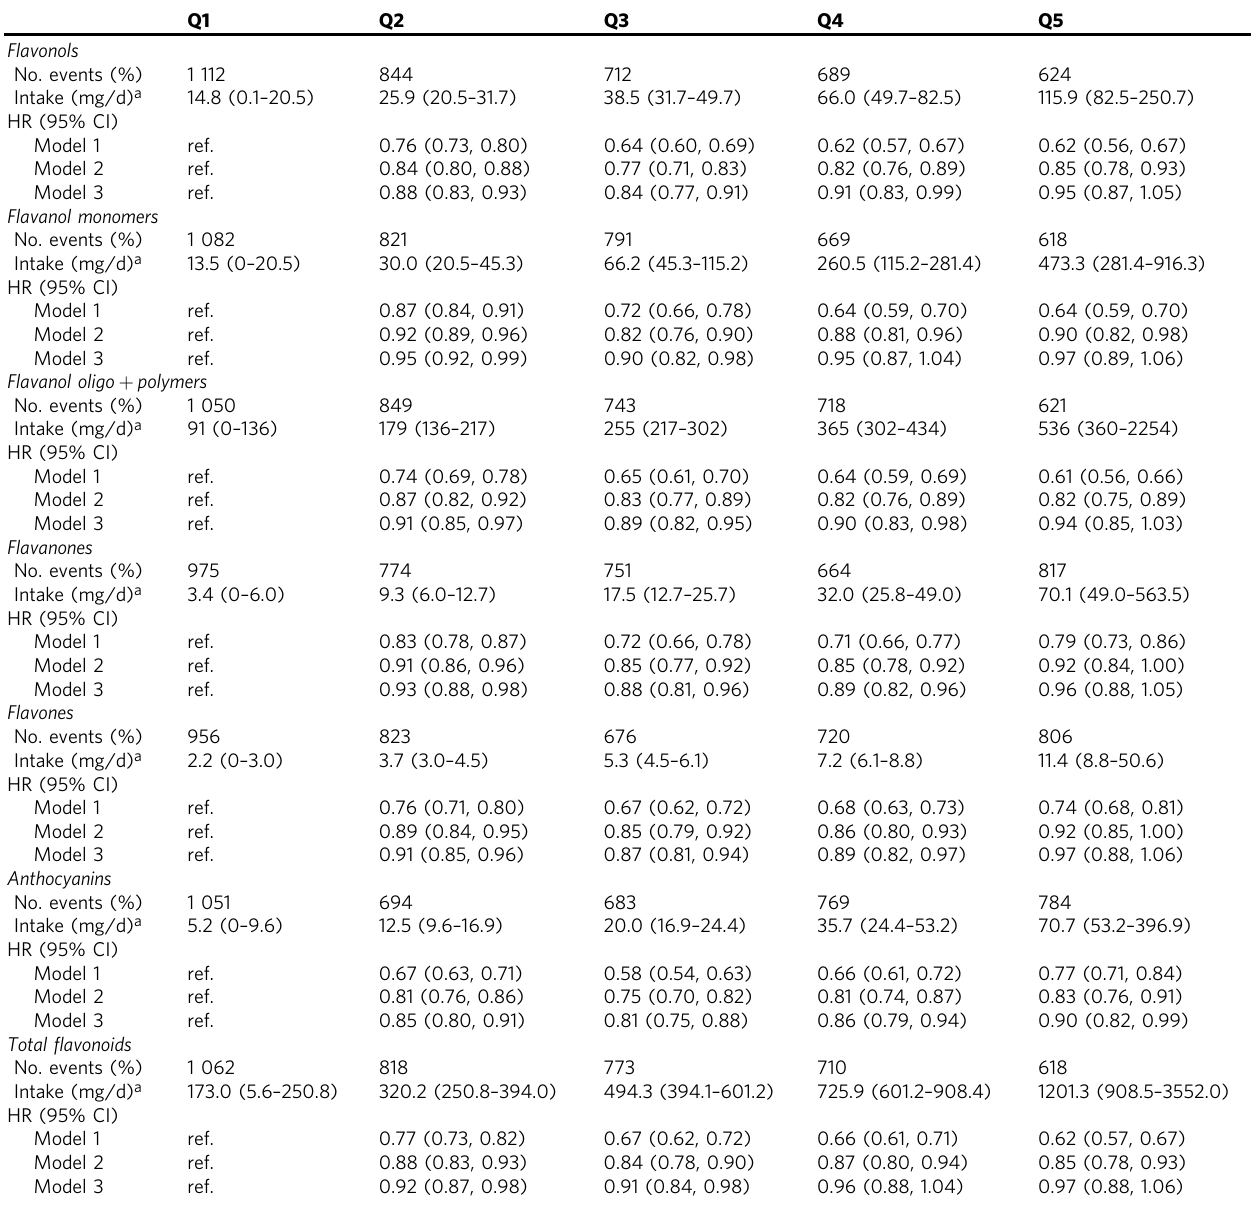
Hazard ratios (95% CI) for 23-year cardiovascular disease-related mortality, in participants without cardiovascular disease at baseline ( n = 52 492), obtained from restricted cubic splines based on Cox proportional hazards models. Model 1 adjusted for age and sex; Model 2 adjusted for age, sex, BMI, smoking status, physical activity, alcohol intake, hypertension, hypercholesterolemia, social economic status(income),diabetes,andprevalentdisease;Model3adjustedforallcovariatesinModel2plusintakesof fi sh,redmeat,processedmeat,dietary fi ber,polyunsaturatedfattyacids,monounsaturated fatty acids, and saturated fatty acids a Median; range in parentheses (all such